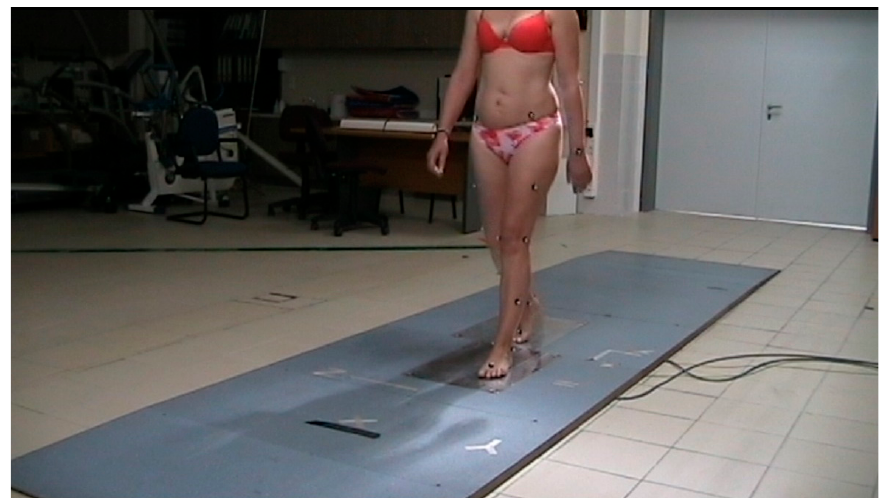
Figure 3. Static position.